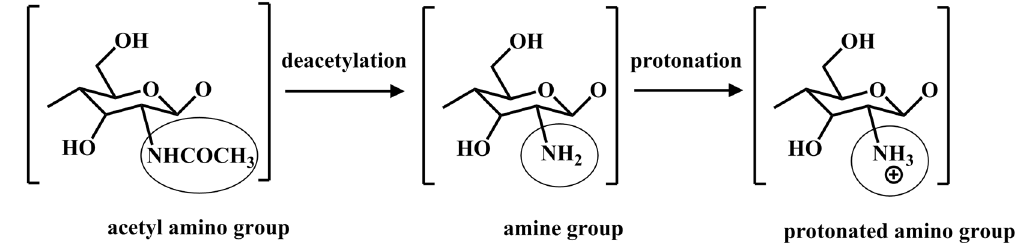
Figure 1. The schemetic of chitosan’s versatility with different functional